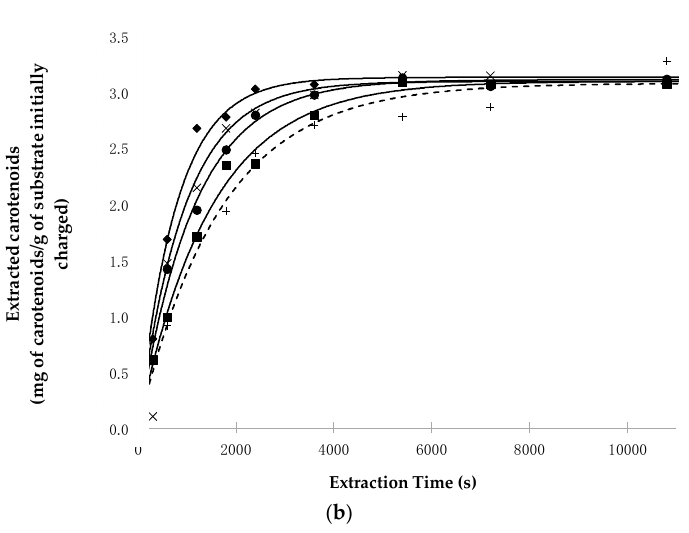
Figure 1. ( a ) Evolution of the experimental and calculated points related to carotenoid extraction from lyophilized fruits of C. annuum L. as a function of extraction time and working conditions ( 40 °C, 40 MPa; 40 °C, 70 MPa; 60 °C, 40 MPa; 60 °C, 70 MPa; Soxhlet extraction n-hexane); ( b ) Evolution of the experimental and calculated points related to carotenoid extraction from lyophilized peels of L. esculentum L. as a function of extraction time and working conditions ( 40 °C, 40 MPa; 40 °C, 70 MPa; 60 °C, 40 MPa; 60 °C, 70 MPa; Soxhlet extraction n-hexane).